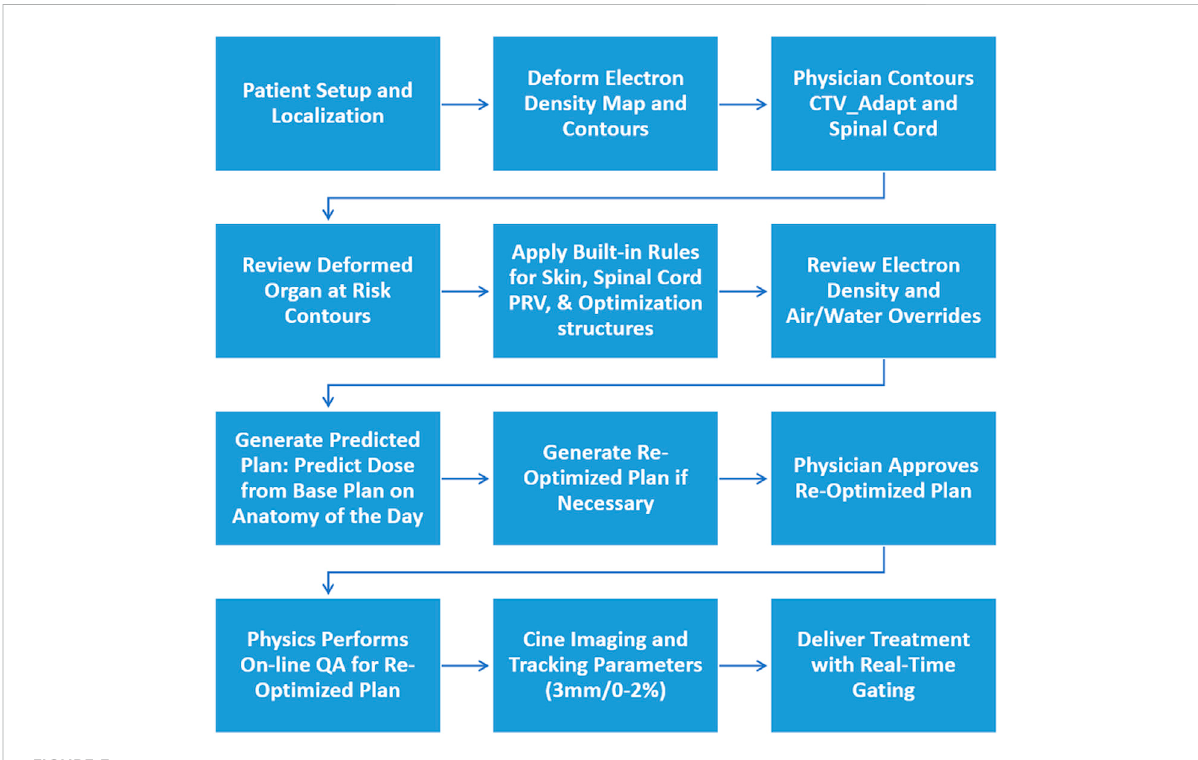
FIGURE 3 The adaptive work fl ow that was followed for the clinical implementation of spine